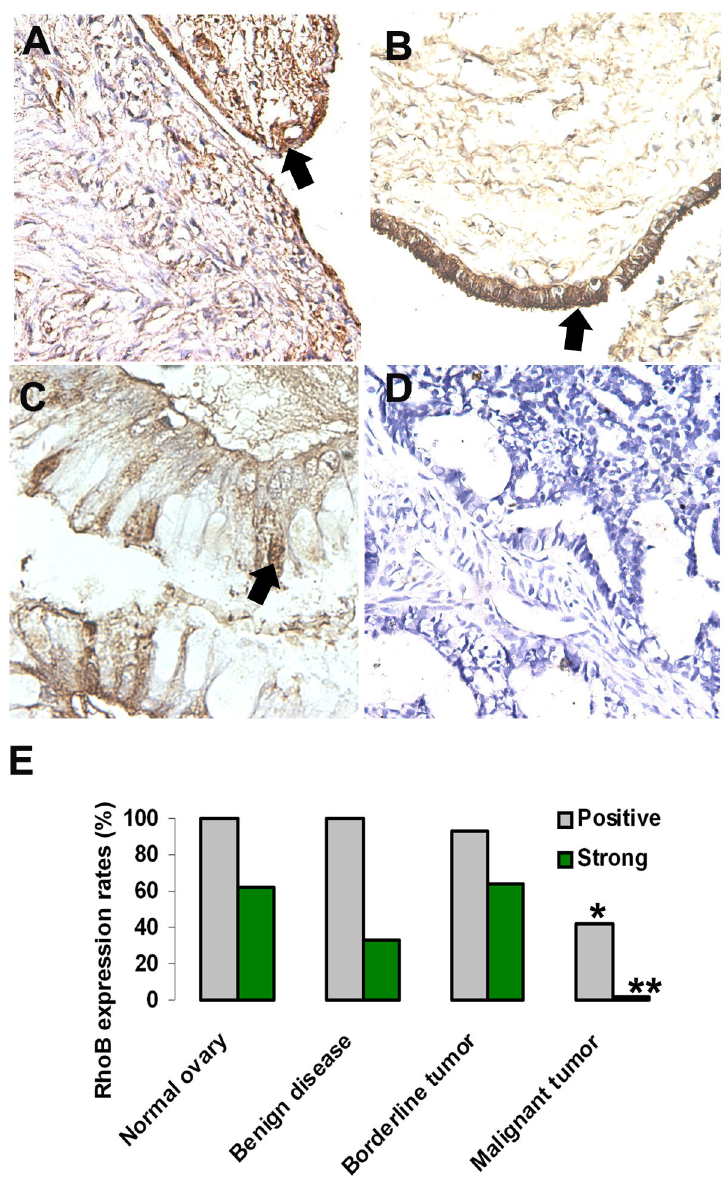
Figure 1. RhoB expression decreases or loss in ovary carcinoma development. RhoB expression levels were analyzed in normal ovaries, benign, borderline tumors and malignant ovary carcinoma respectively. Immunohistochemistry reveals that moderate or strong cytoplasmic expressions of RhoB were detected in most of the normal ovaries (A) and benign (B, serous cystadenoma) and borderline (C) tumors. Staining was well visualized along ovary epithelium (arrows), with negative (D) or weak expression in malignant invasive tumor. (E) It is clear that RhoB expression is detected in normal ovary epithelium (100%), benign diseases (100%), borderline tumors (92.8%), and decreases significantly in the malignant invasive tumors (42.1%, * P <05). doi: 10.1371/journal.pone.0078417.g001 RhoB gene expression. However, RhoB gene self-silencing in ovary cancer cells was significantly reversed by TSA. MTT